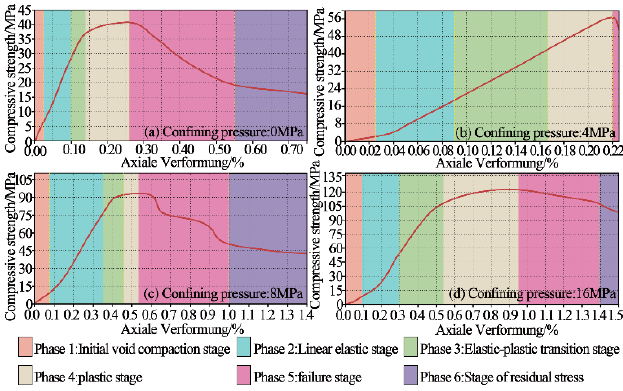
Figure 12. Total stress – strain curves of fine sandstone (group #3).